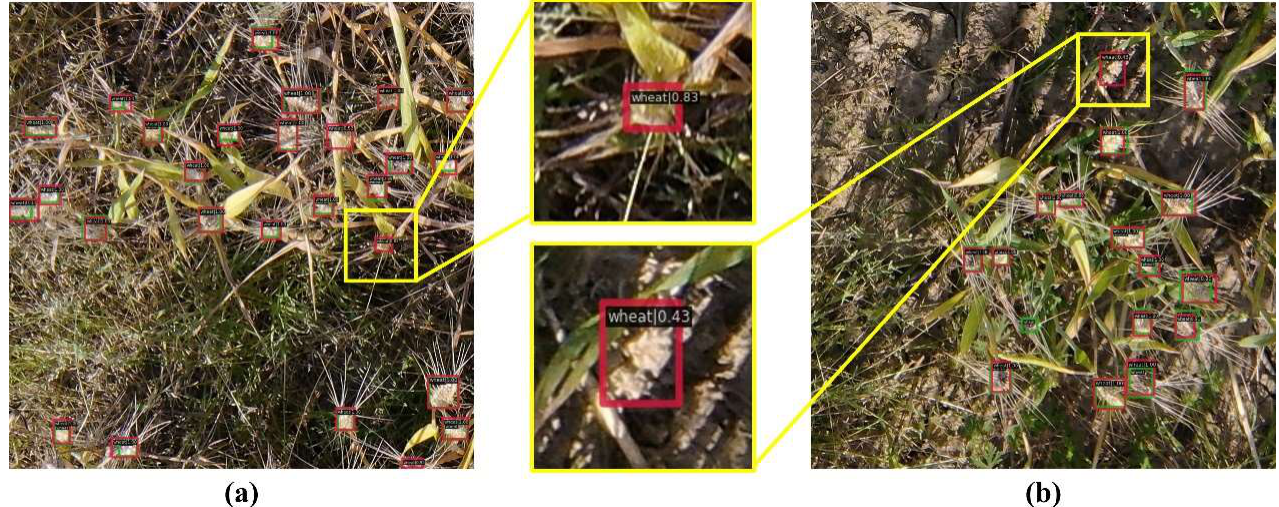
Figure 7. Special detection results of UWHD. ( a ) The FR-Transformer method performs well even without the ground truth bounding box, ( b ) due to the dual effects of light and ground soil, the FR-Transformer method is mistaken for wheat heads, research and application should avoid this situation (the green bounding box in the image represents the ground truth of the wheat head, and the red bounding box represents the predicted wheat head region). Table 5. Performance comparison of F-Transformer on input images of different